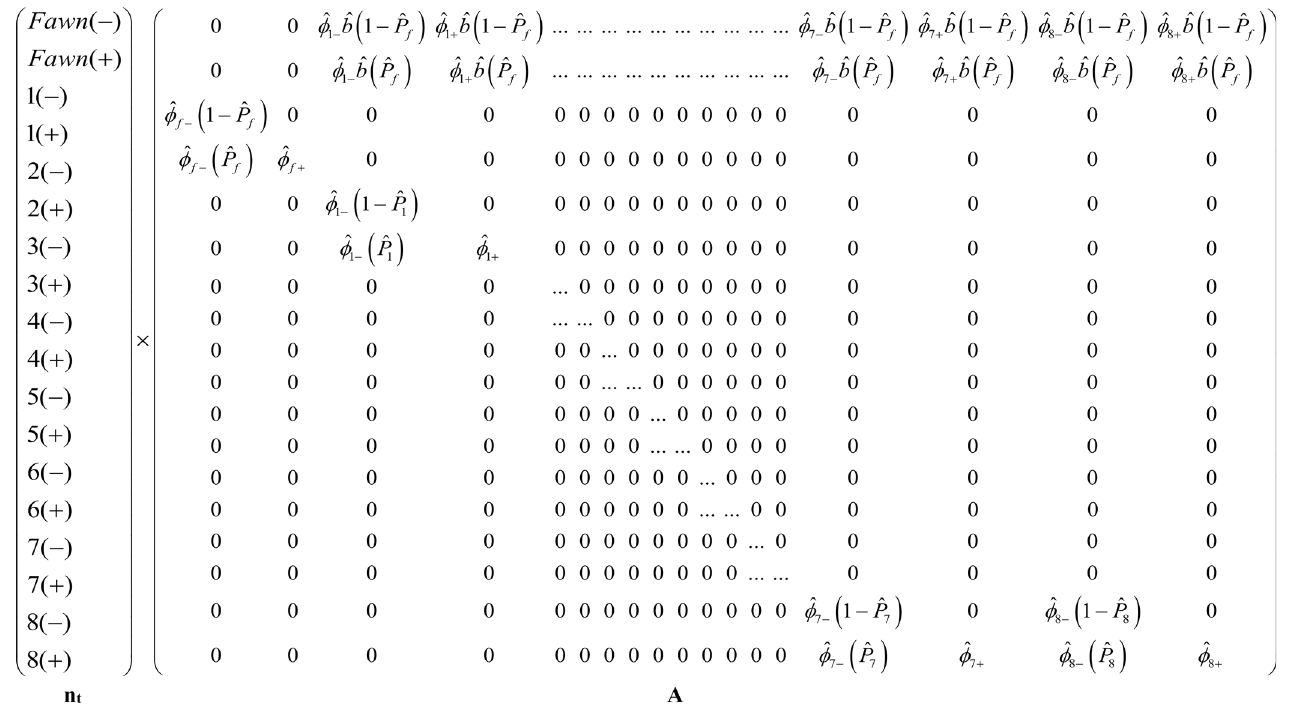
Fig 1. Leslie Matrix Population Model. Post-breeding, age-structured, female-dominated 18x18 Leslie Matrix model of white-tailed deer population on Deer Creek drainage SW of Glenrock, WY (2003 – 2010) that was located within the chronic wasting disease (CWD) endemic area. n t represents the number of deer in each age class by CWD-status ((-) = PrP CWD not detected, (+) = PrP CWD detected). ^ (cid:1) i ð(cid:5) = þÞ represents estimated survival by age class, i , and CWD-status (- or +), ^ b is the estimated fecundity rate and ^ P i is the age-speci fi c CWD incidence rate.